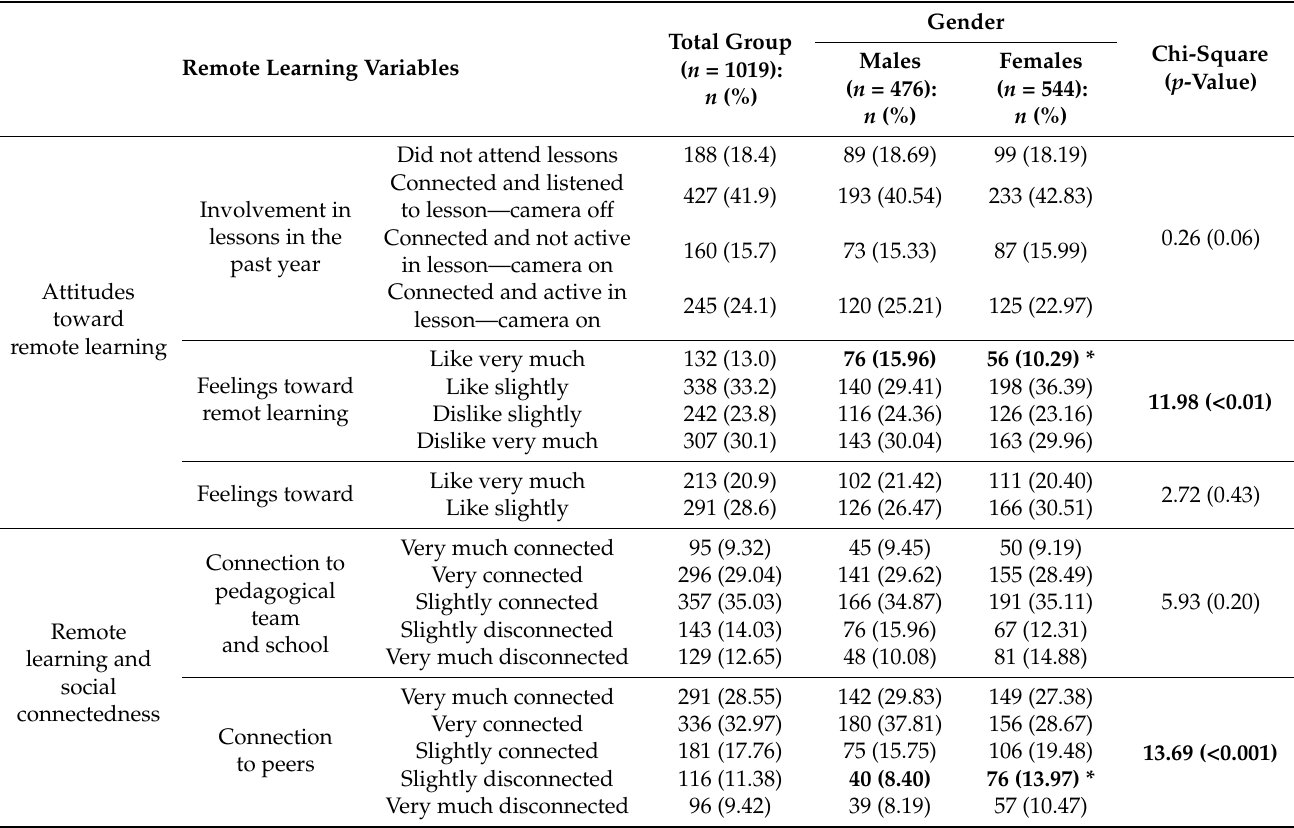
Table 4. Gender differences related to the remote learning